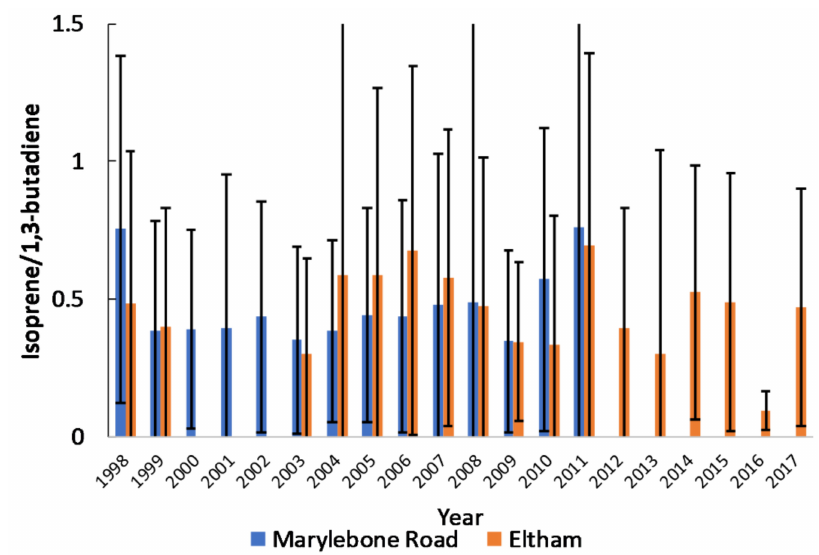
Figure 2. Yearly variation of the limiting anthropogenic molar ratio of isoprene and 1,3-butadiene based on winter-time data (see text). Note: There are no available winter data of the time series of 2000–2002 and 2012–2017 for Eltham and Marylebone Road, respectively. The error bar represents ± 1 SD of the whole data series.